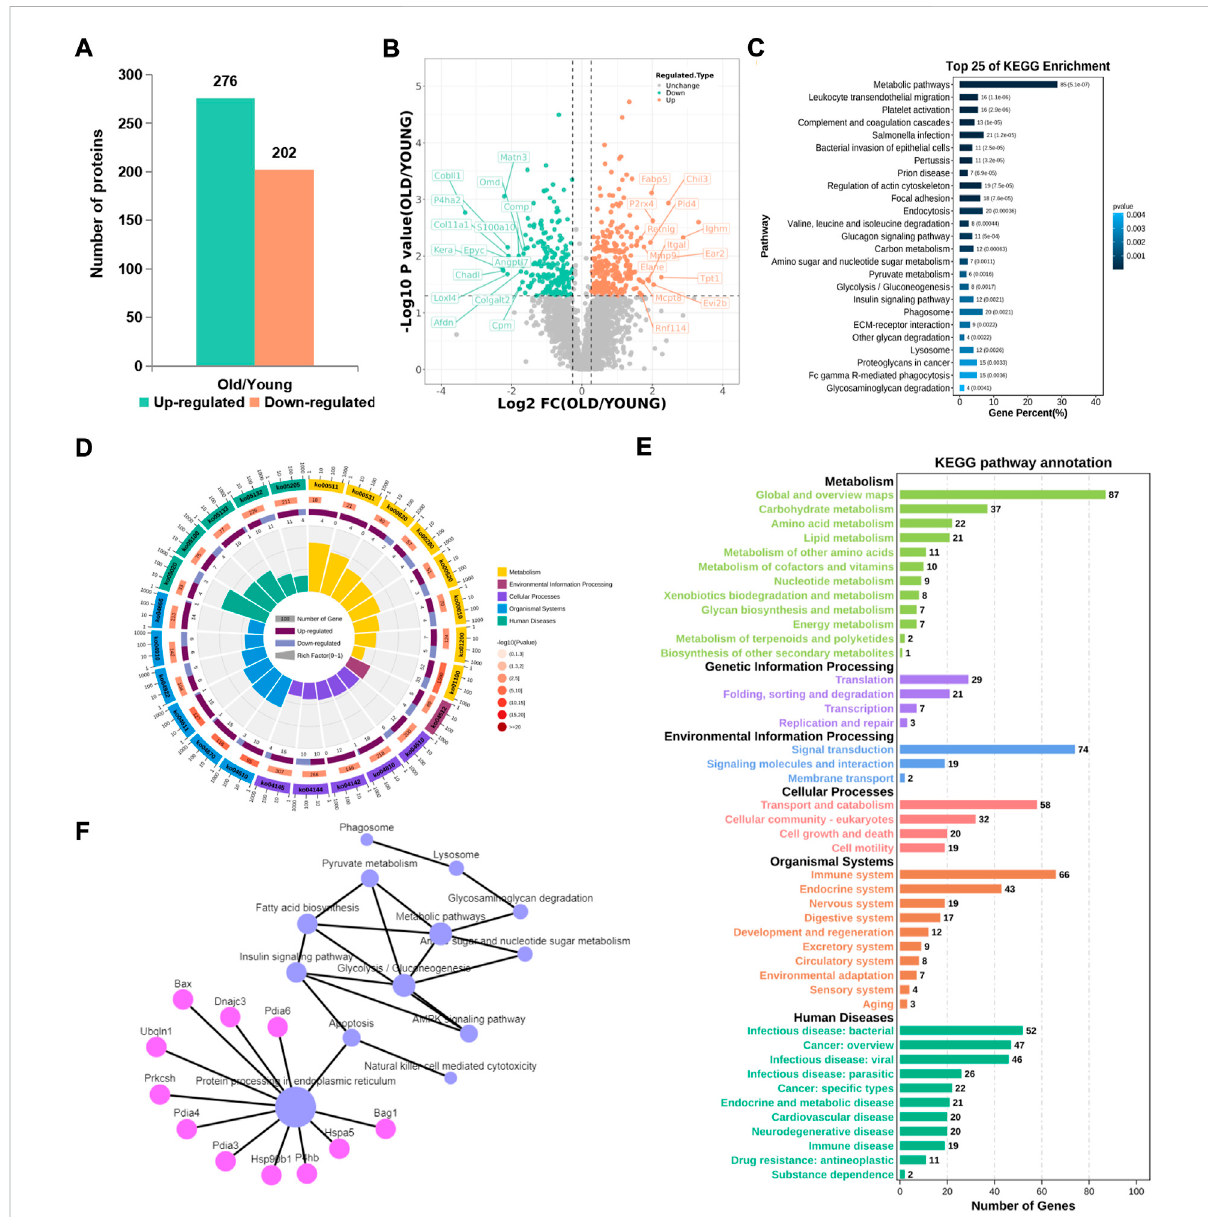
FIGURE 3 KEGG pathway analysis of proteins with signi fi cant difference. (A) Number of differential proteins in articular cartilage after aging (Ratio > 1.2, p < 0.01). (B) Volcano plots showing differential proteins. (C) Top 25 KEGG pathways of differential proteins. (D) The radar chart showed the relationship betweenupregulatedanddownregulatedgenesandtheKEGGpathway. (E) Sub-termsincludedintheradarchartterm. (F) NetworkanalysisofKEGG